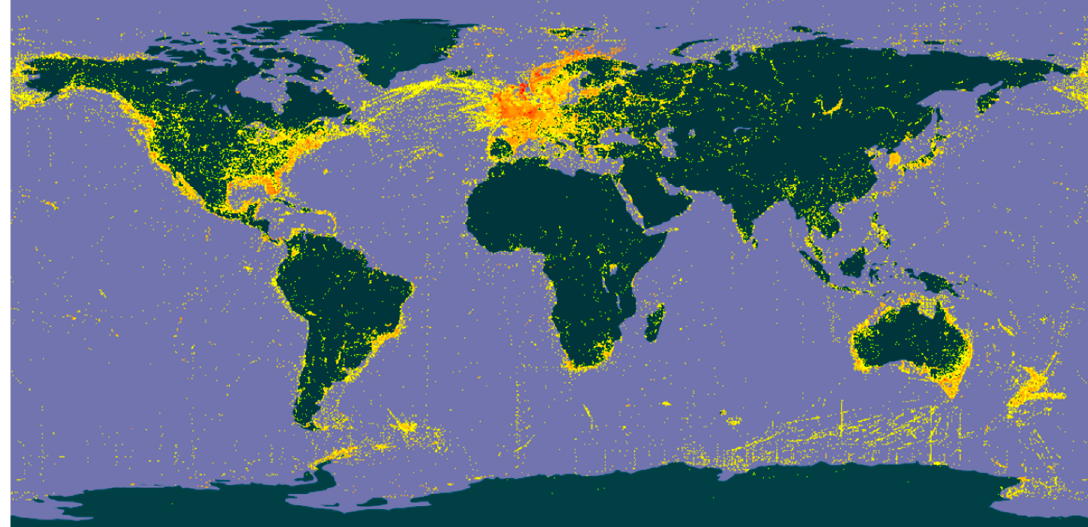
Figure 4. Occurrence data from Global Biodiversity Information Facility (GBIF) with 813,947 georeferenced records for Annelida in the marine and terrestrial environments. In red and orange, hotspots of occurrences, in yellow sites with one occurrence. This map does not show the real knowledge about annelid records, but those uploaded in this platform. However, it can be used as a proxy of the current number of undertaken surveys.